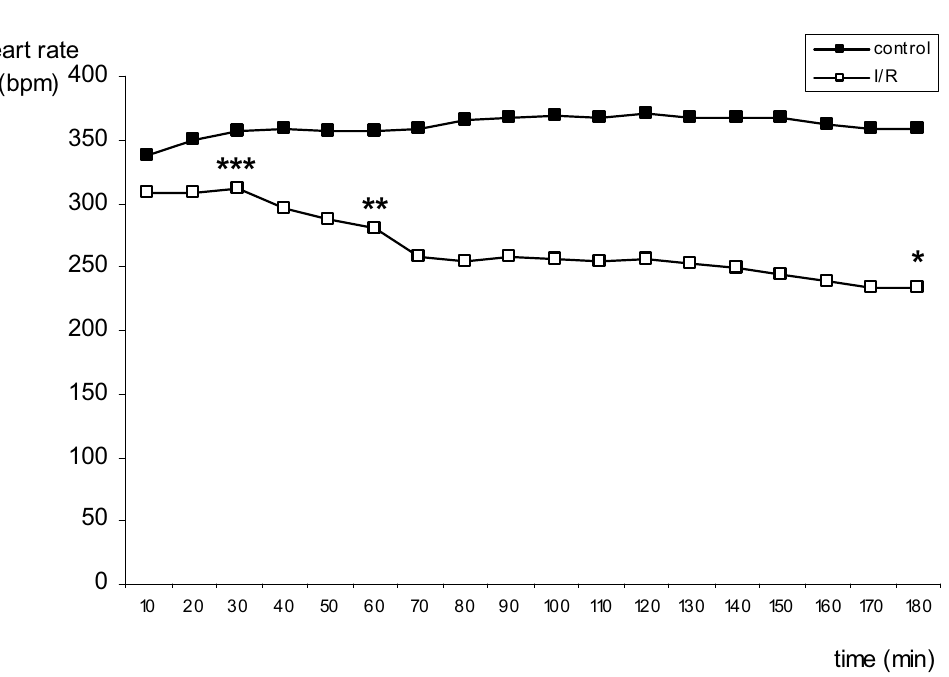
FIGURE 5 – Mean heart rate (bpm) along time. Asterisk indicates significant differences according experimental time in I/R group (p < 0.05)